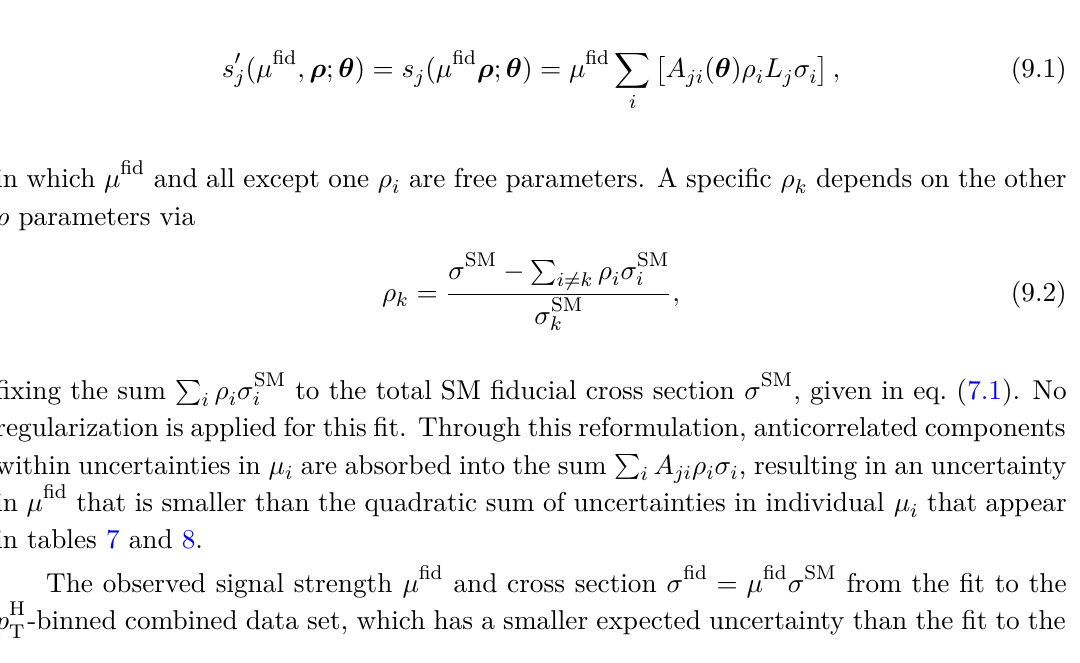
Figure 3 . Correlation among the signal strength modifiers in bins of fiducial p H (right). For the p H matrix, results of the regularized and unregularized fits are given above and T below the